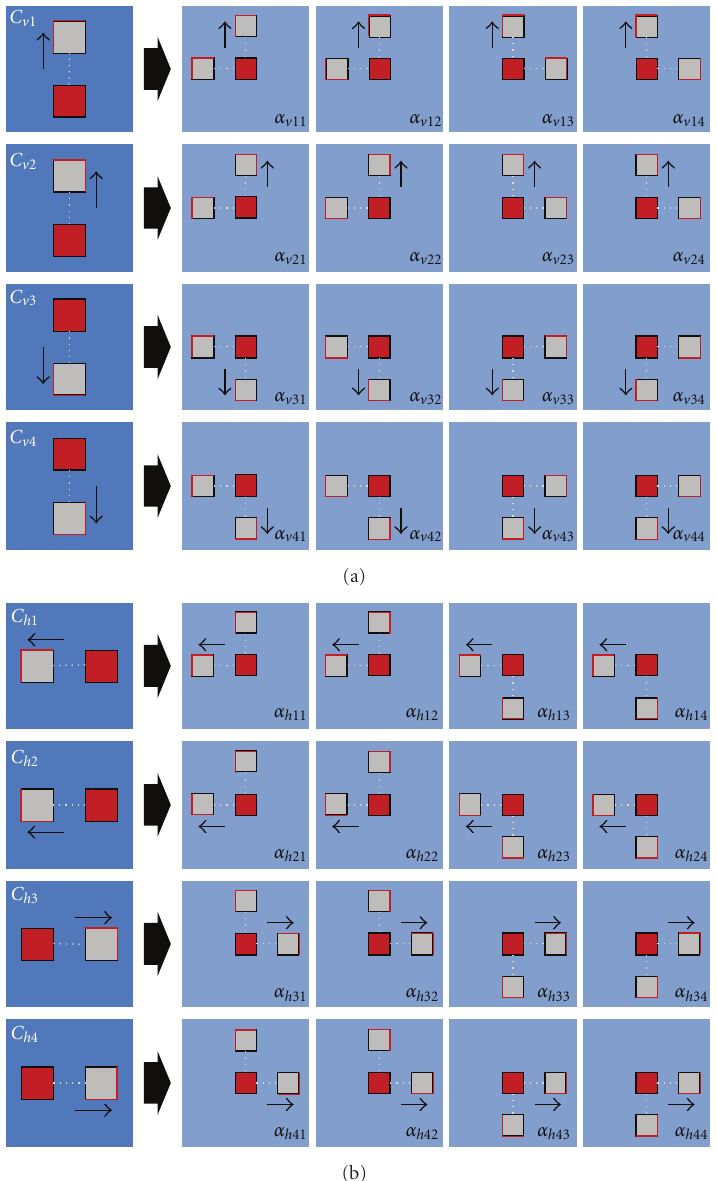
Figure 7: 32 patterns of states which are set “undesirability” parameters (undesirability of each of the 8 kinds of characteristic shapes is given by 4 parameters).